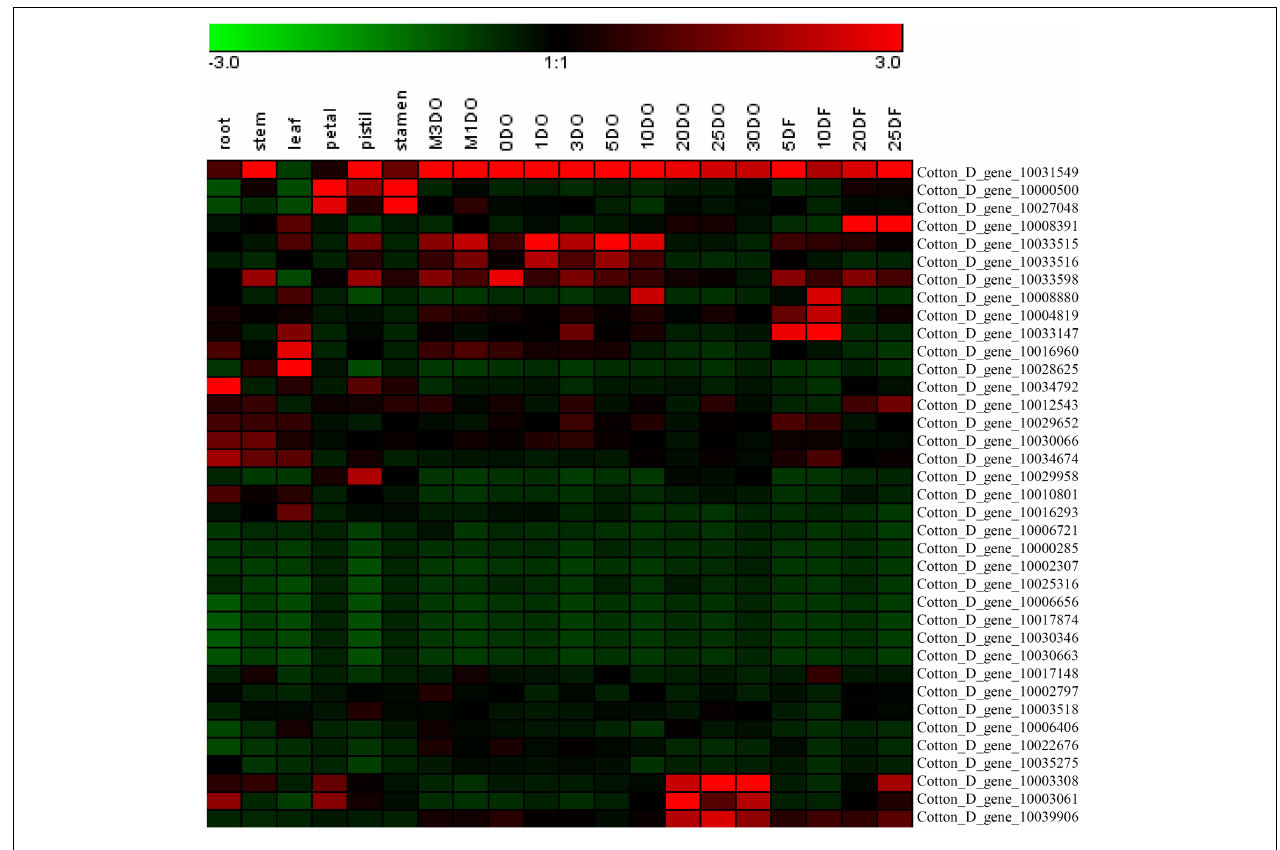
FIGURE 1 | Heat map representation for expression patterns of Gossypium raimondii TCP genes in 20 representative tissues. The heat map, generated with Genesis, shows the hierarchical clustering of GrTCPs in root, stem, leaf, petal, pistil, stamen, ovule and fiber tissues. M3DO, M1DO, 0DO, 1DO, and 3DO: ovules attached with fibers at -3, -1, 0, 1, and 3 days post-anthesis; 5DO, 10DO, 20DO, 25DO, and 30DO: ovules without fibers at 5, 10, 20, 25, and 30 days post-anthesis; 5DF, 10DF, 20DF, and 25DF: fibers at 5, 10, 20, and 25 days post-anthesis. The reads per kilobase of transcript per million mapped reads values were log10 transformed and indicated the expression level of GrTCPs genes, while the gradient color (red/black/green) reflects the expression levels (high to